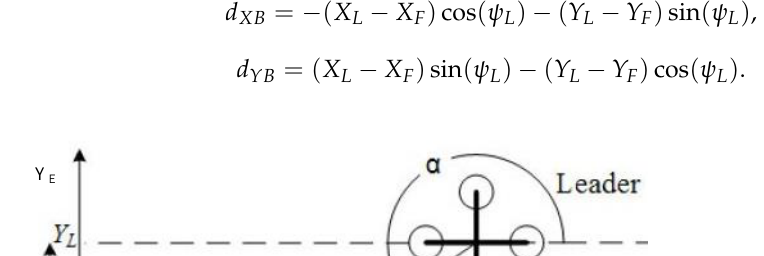
. Figure 3 is a schematic diagram of the quadrotor formation world